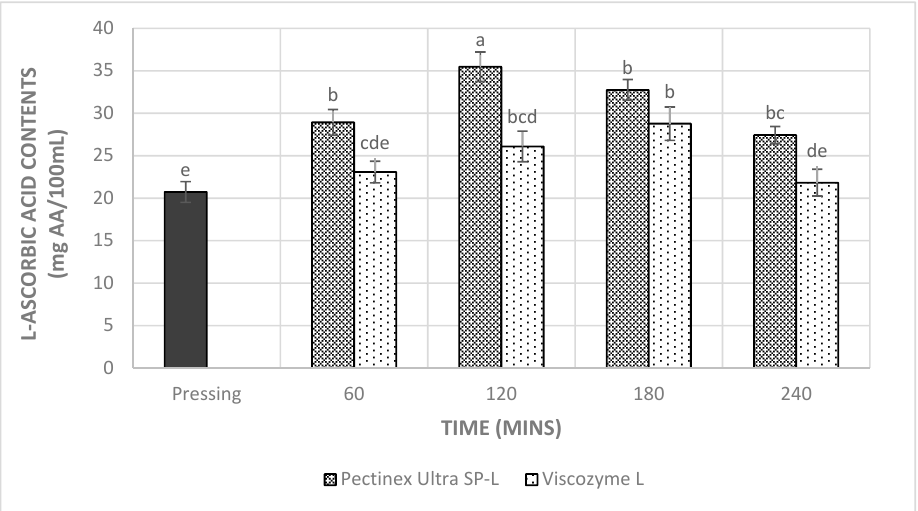
Figure 4. The effects of enzyme treatments on the L -ascorbic acid contents of mulberry juice. The values are mean ± SD ( n = 3). Means sharing different letters are significantly different ( p < 0.05).